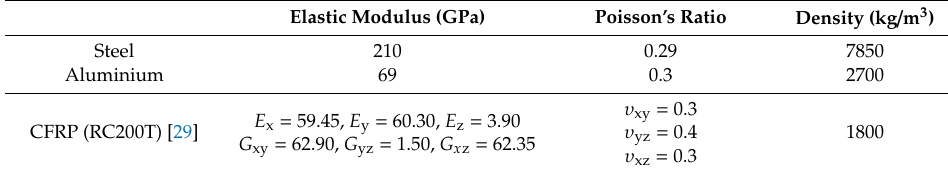
Table 1. Properties of the materials used in the vehicle structure. (Material breakdown in Figure